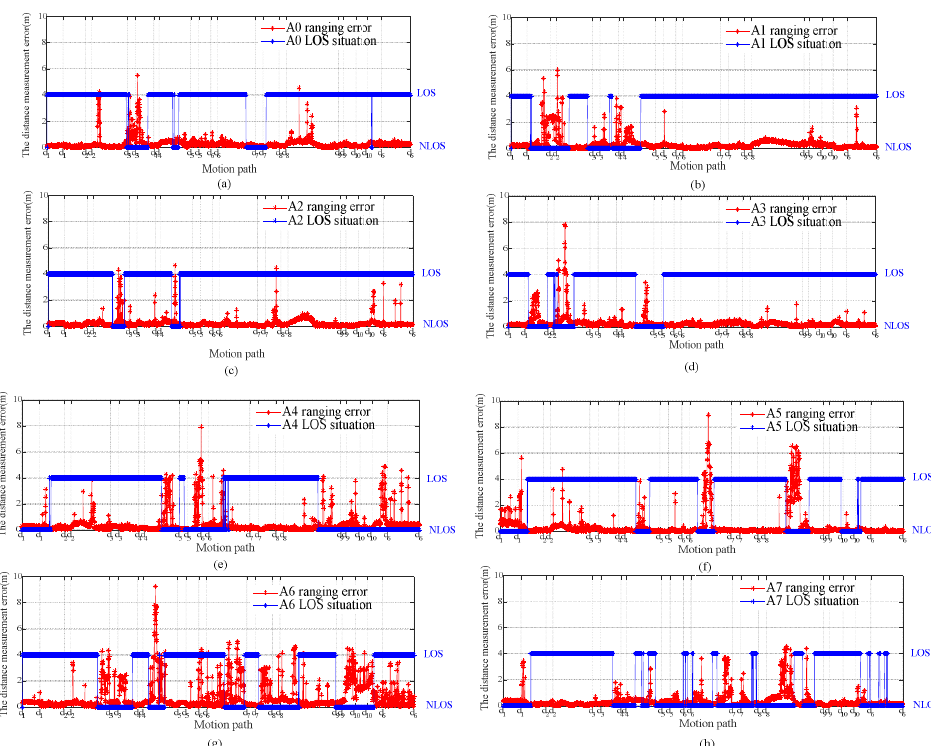
Figure 20. Comparison of LOS selection and ranging error of each anchor under the path of Experiment 2. ( a ) A0 situation; ( b ) A1 situation; ( c ) A2 situation; ( d ) A3 situation; ( e ) A4 situation; ( f ) A5 situation; ( g ) A6 situation and ( h ) A7 situation.